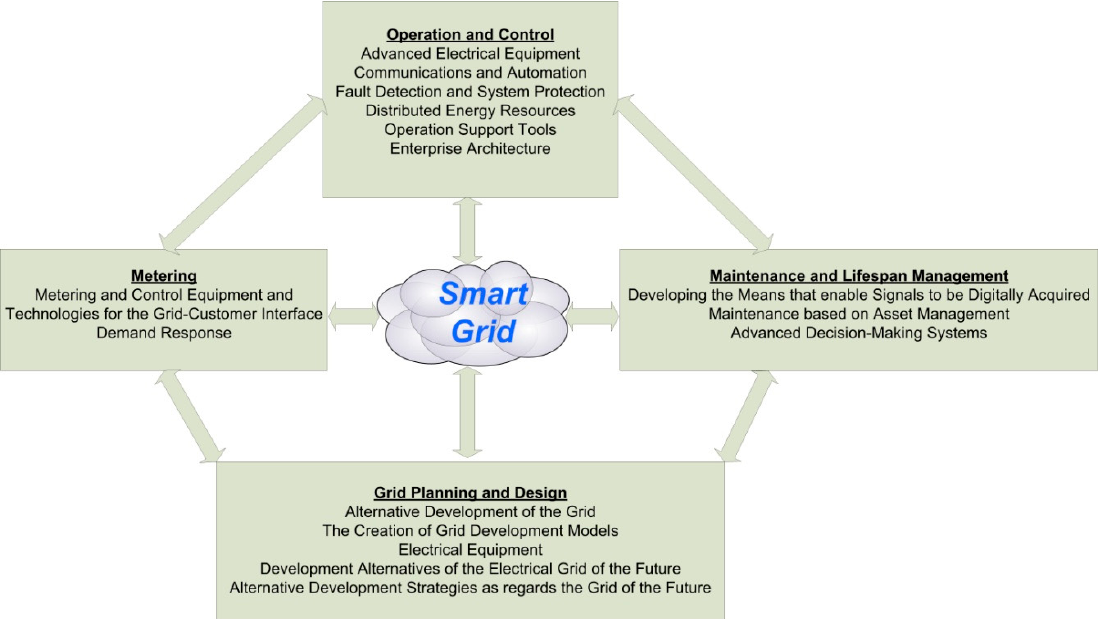
Figure 1. Research areas of SGs. The arrows indicate that all areas are interrelated, since SG can serve information from one area to another.